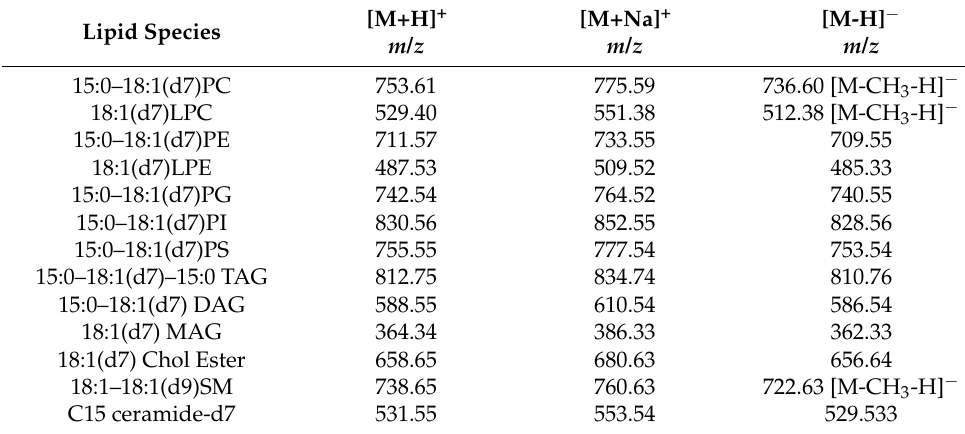
Table 2. List of the mixture of 13 deuterated lipid tested with compounds under investigation. The theoretical values of positive protonated adduct, sodiated adduct, and negative deprotonated adduct are given. For PC, LPC, and SM, the demethylated negative adduct is reported. PC: